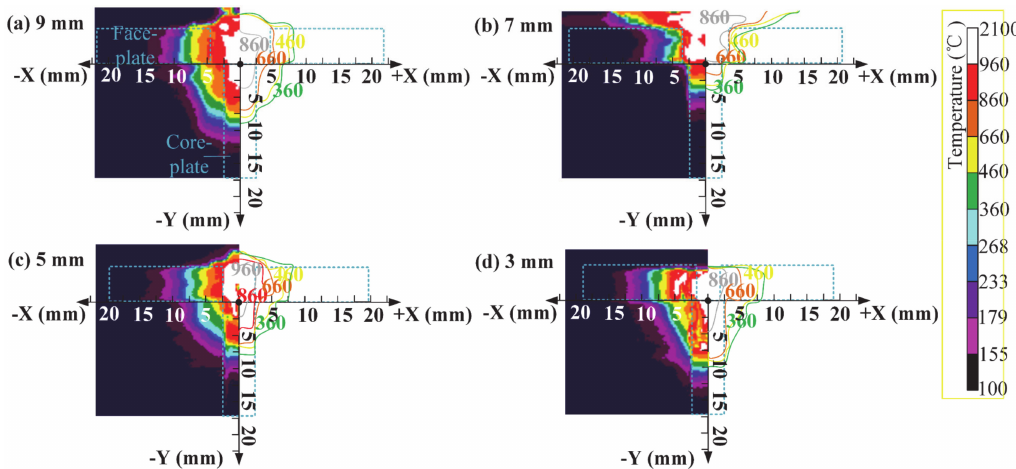
Figure 12. Temperature distribution of FBCA welding T-joint cross-sections under di ff erent groove